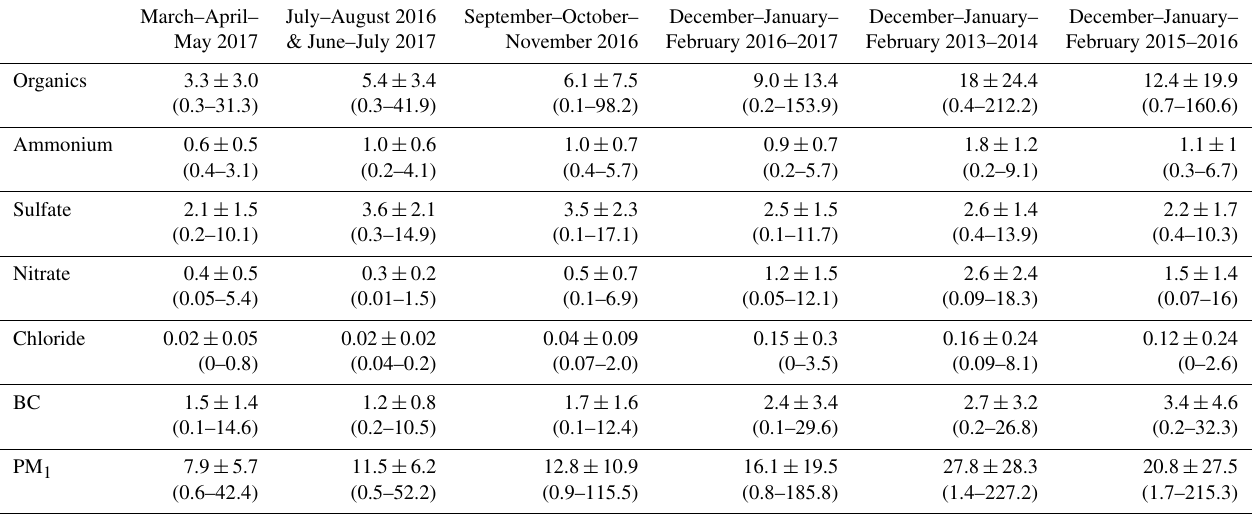
Table 1. Seasonal average concentrations ± standard deviation (range) and total mass of the main submicron aerosol components for the 1-year study period and the two winter campaigns.